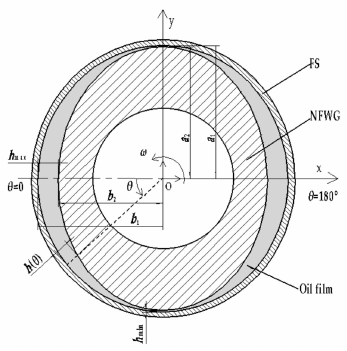
Figure 2. The ESB model of the simplified structure between the NFWG and